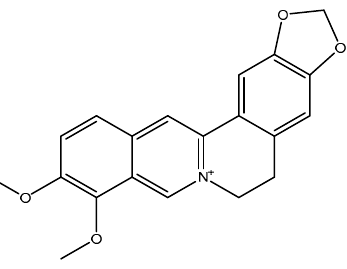
Figure 9. Chemical structure of berberine.